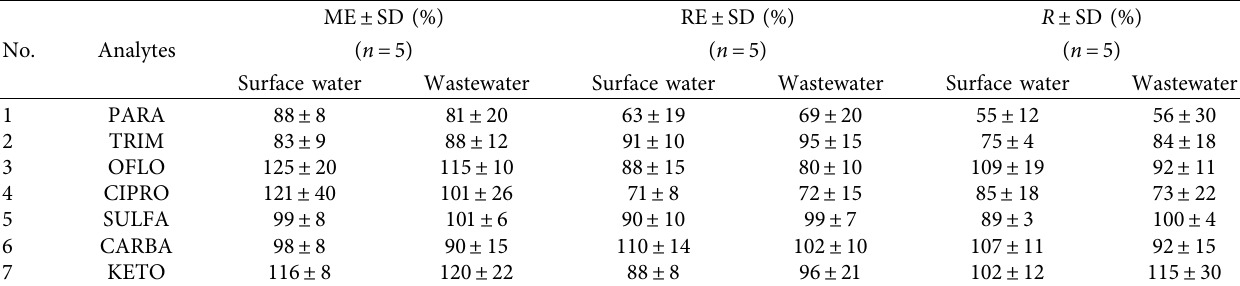
Table 3: Matrix effect (ME), extraction recovery (RE), and overall recoveries ( R ) of target compounds. No.